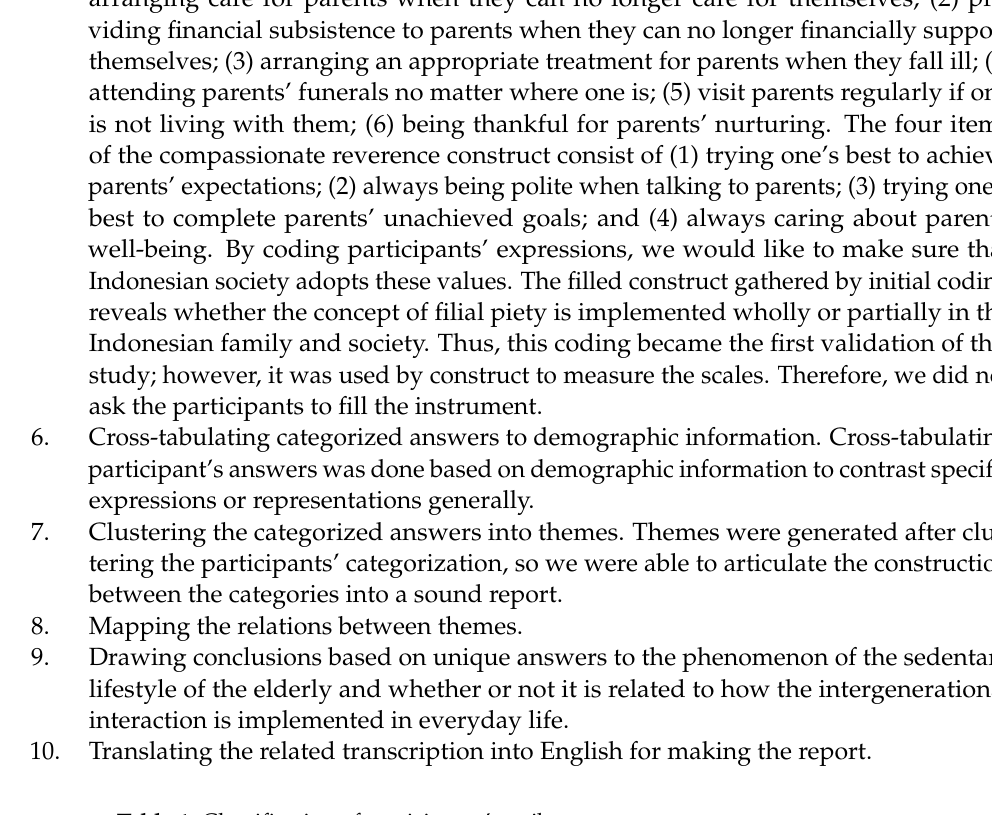
Table 1. Classification of participants’